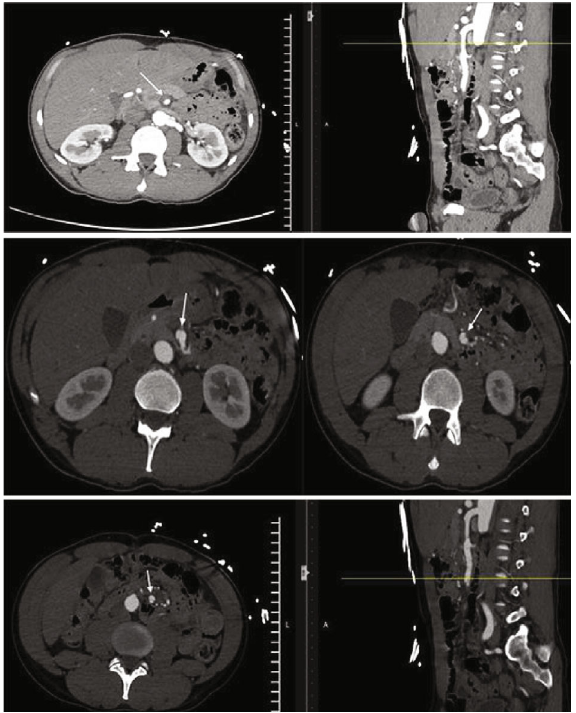
Figure 1: SISMAD within the proximal-to-mid SMA with a 3 cm segment along the proximal SMA with thrombosis of the false lumen extending craniocaudally; 70% stenosis of the proximal SMA; an intimal fl ap was seen intermittently below this level extending to the major bifurcations of the middle colic